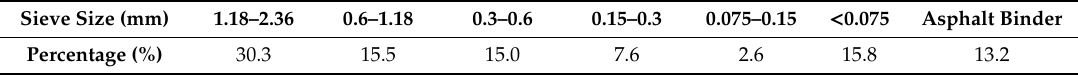
Table 1. Percentage of materials used in asphalt mortar.